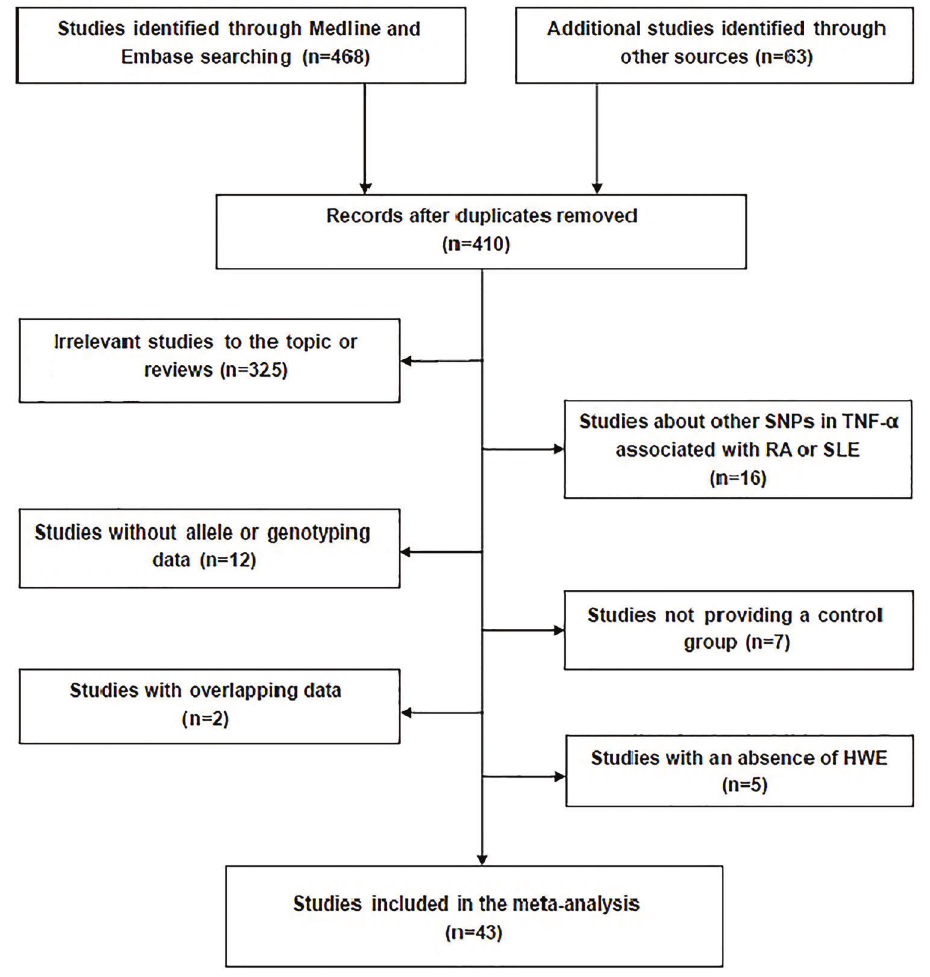
Figure 1. Flow chart illustrating the selection of articles included in the meta-analysis. SNP: single-nucleotide polymorphisms; RA: rheumatoid arthritis; SLE: systemic lupus erythematosus; HWE: Hardy-Weinberg equilibrium.